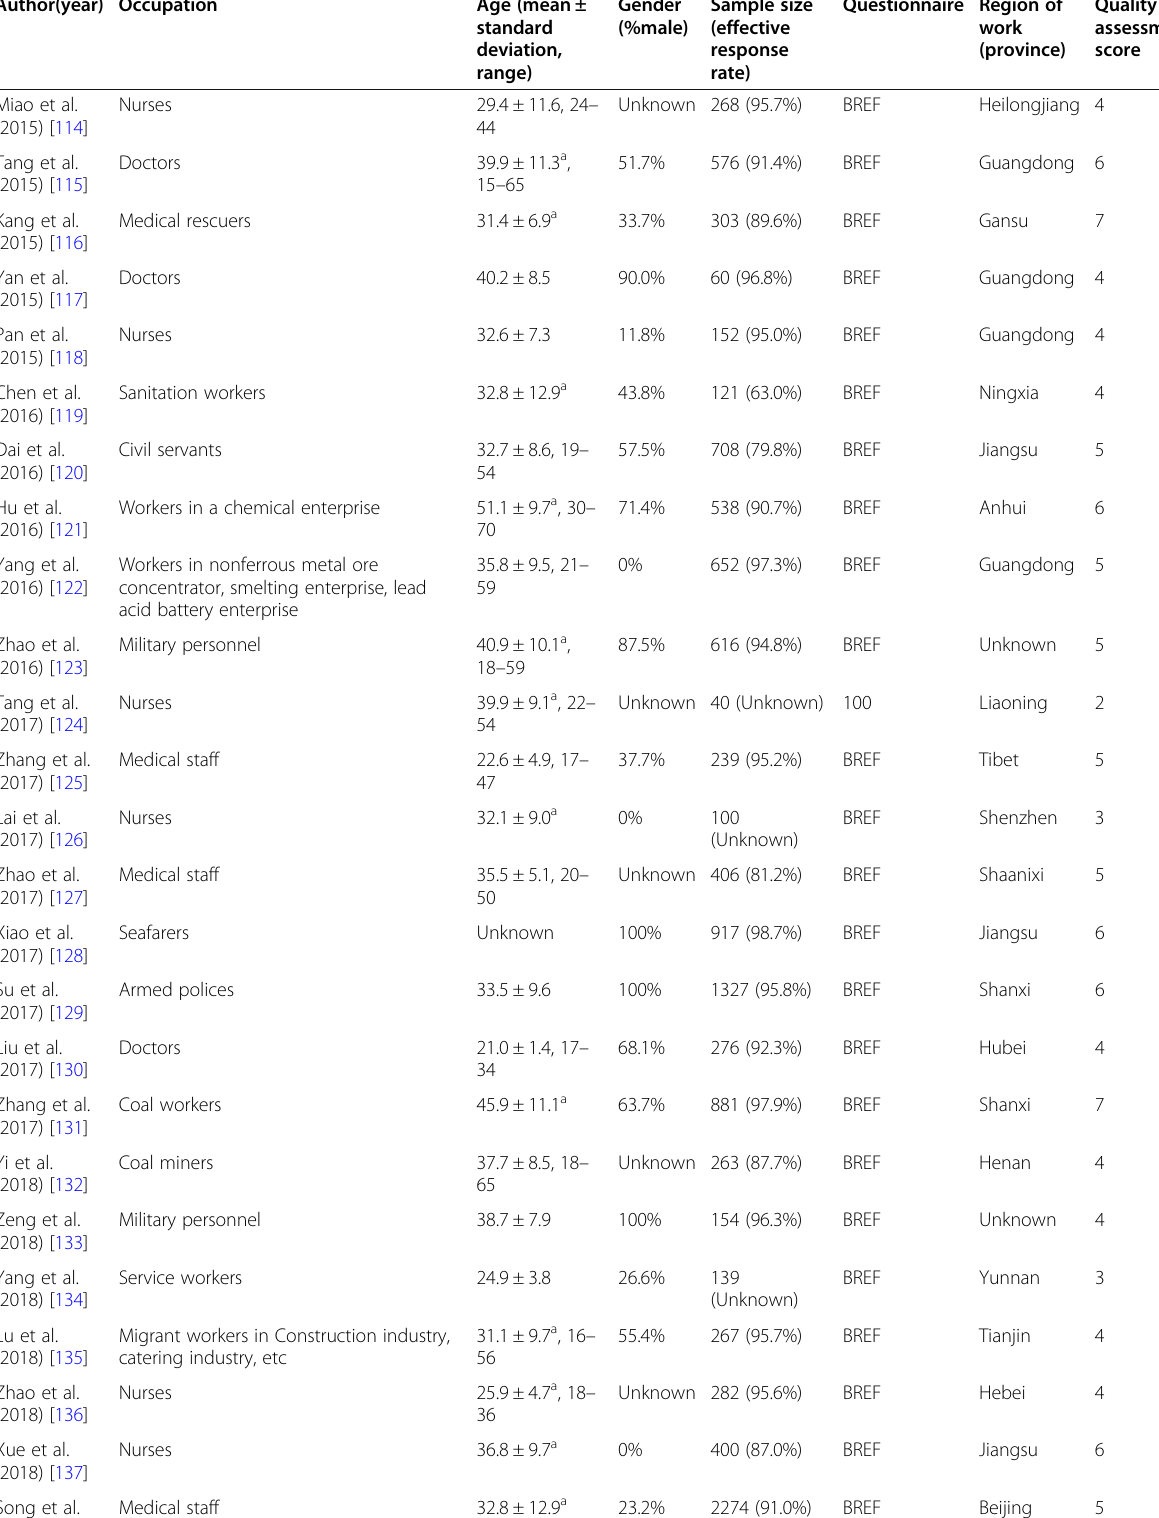
Table 2 Descriptive characteristics and quality assessment of the included publications